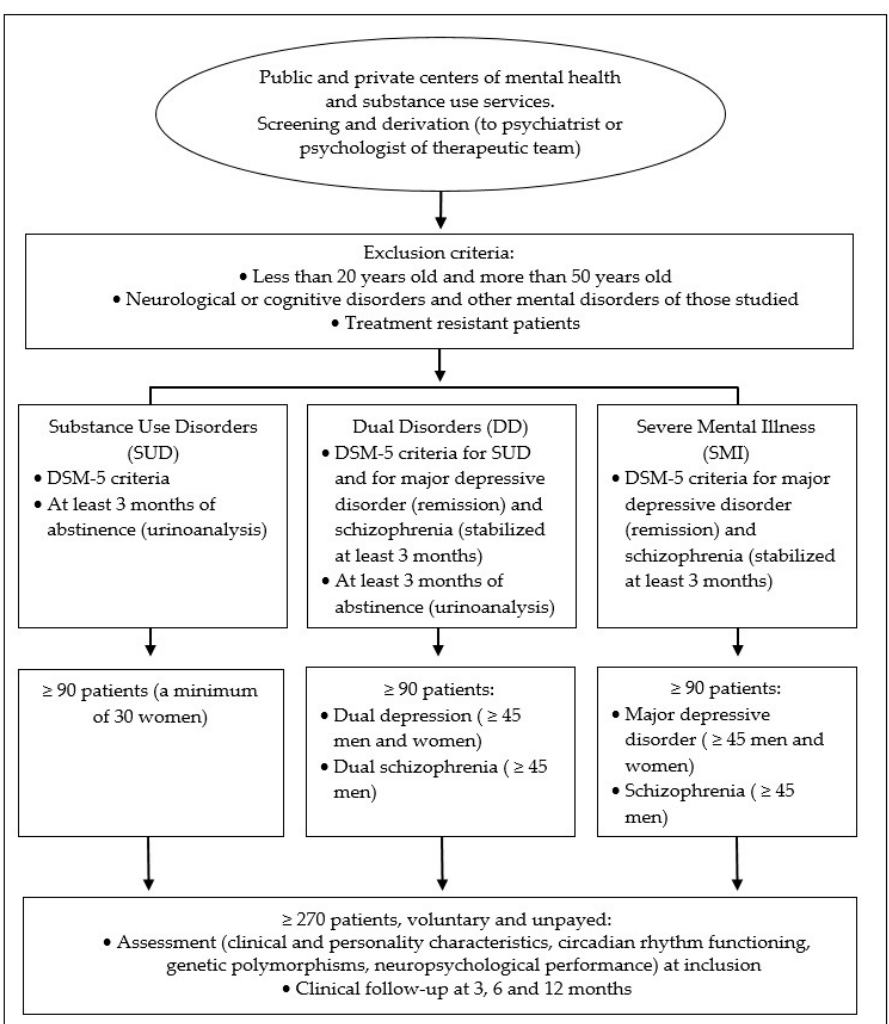
Figure 1. Inclusion and exclusion criteria of the groups of patients participating in Study